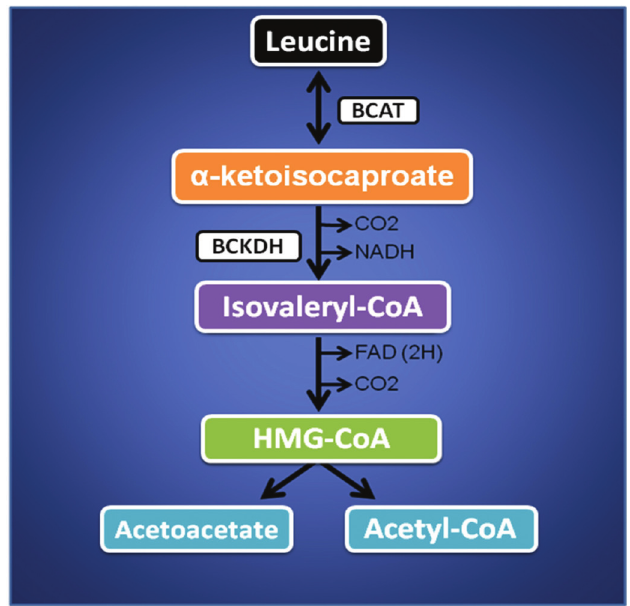
FIGURE 1 – Leucine metabolism. Adapted from Smith, Marks and Liberman